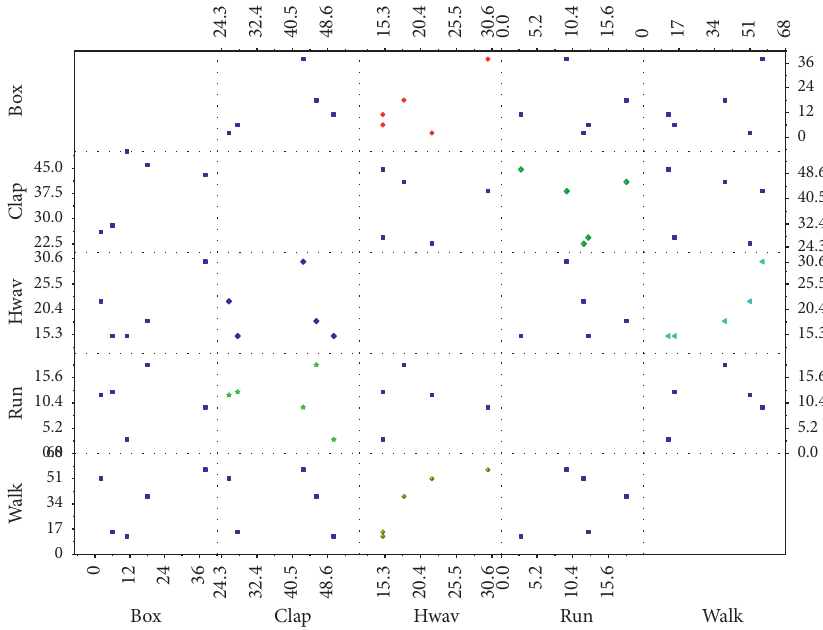
Figure 9: Confusion matrix of SFS results in false motion recognition.